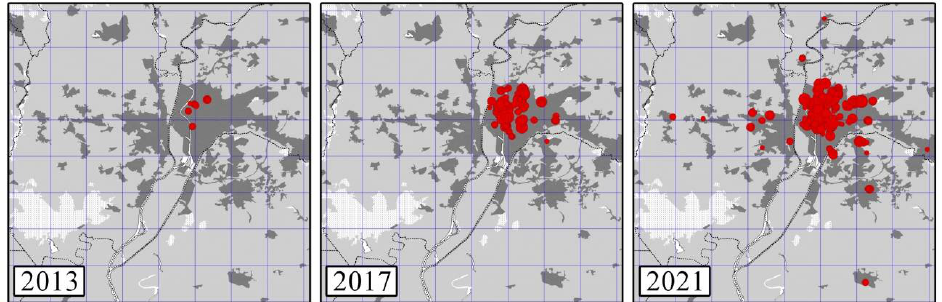
Figure 4. Distribution of monk parakeet nests (red dots) in the study area over years. The size of dots increases with the number of chambers per nest (from 1 to 16).